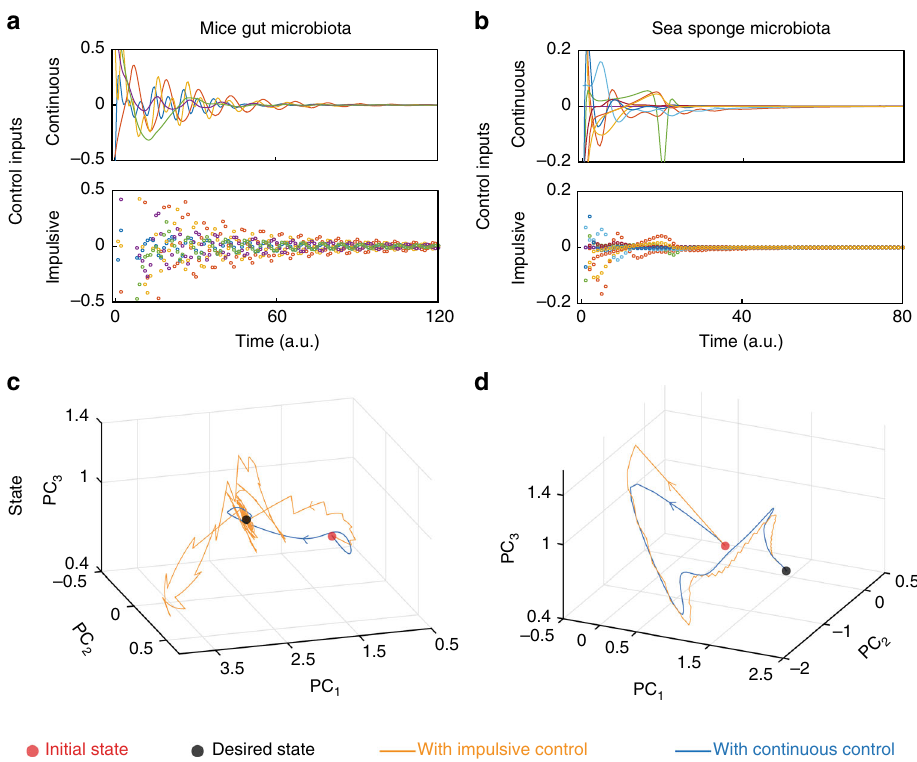
Fig. 6 Controlling host-associated microbial communities. The controlled population dynamics of both microbial communities were simulated using the controlled GLV equations (see Supplementary Note 7 for details). The intrinsic growth rates were adjusted such that the community has an initial “ diseased ” equilibrium state x C. dif fi cile for the mice gut microbiota) is overabundant compared to the rest of species. We chose the 0 in which one species ( desired state x d as another equilibrium with a more balanced abundance pro fi le. For each microbial community, we used the minimum set of driver species identi fi ed in Fig. 3. a , b Control inputs obtained using the linear MPC for the impulsive and continuous control schemes. c , d Projection of the high- dimensional abundance pro fi les (states of the microbial communities) into their fi rst three principal components (PCs). See Supplementary Figure 1 for the temporal response of each species. The calculated control strategies applied to the driver species succeed in driving the community to the desired state, using either continuous or impulsive